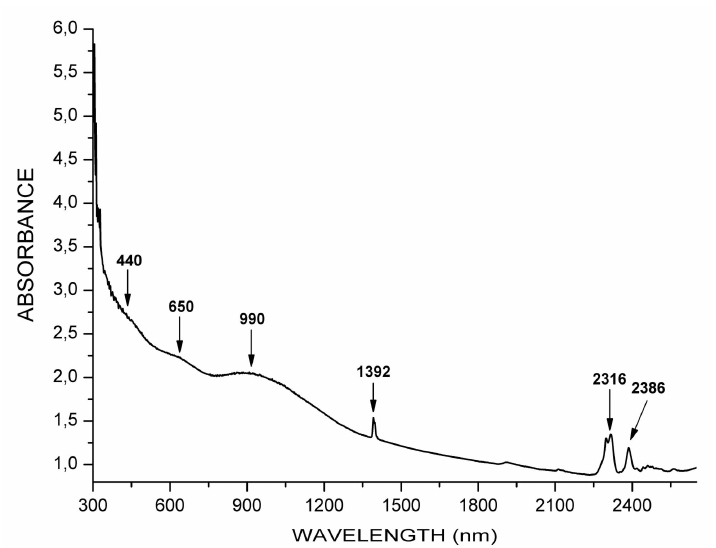
Figure 7. Optical absorption spectrum of the nephrite from the Bazhenovskoye